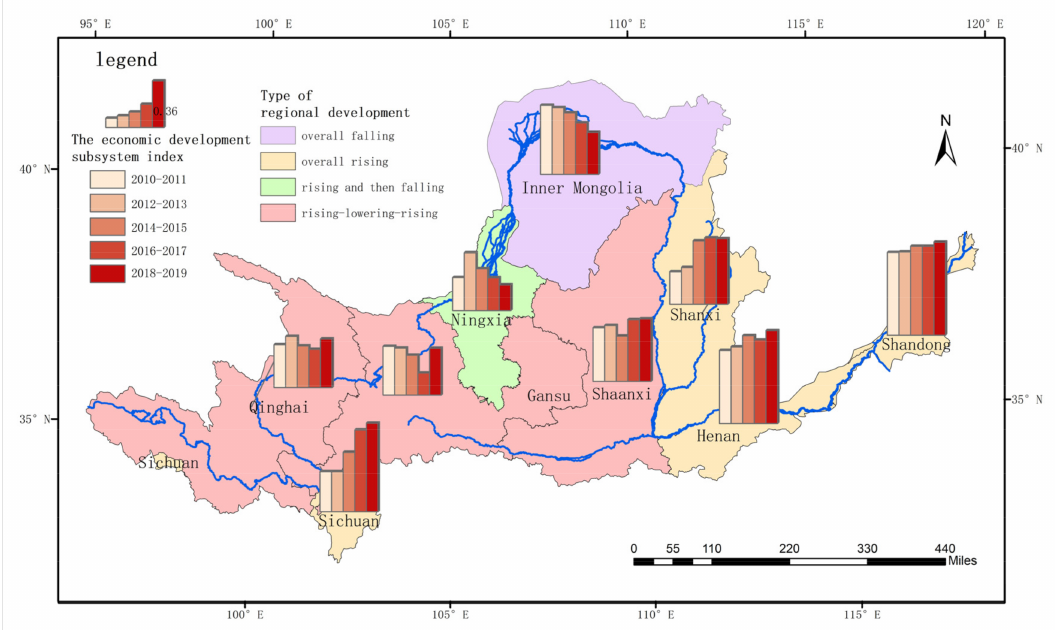
Figure 3. Evaluation of high-quality economic development in the provinces in the Yellow River basin from 2010 to